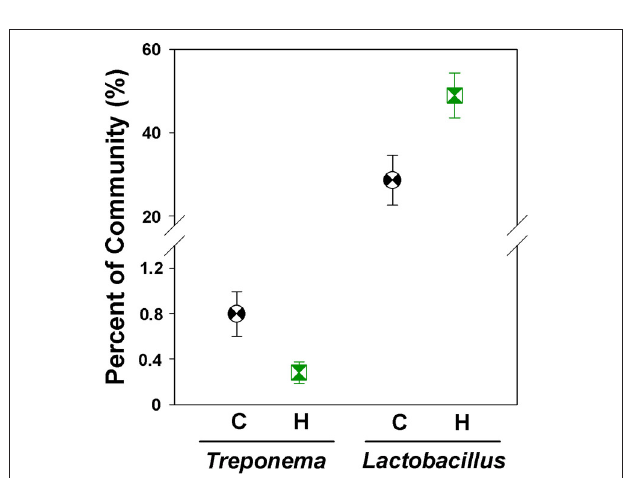
FIGURE 6 | Relative abundances of Treponema and Lactobacillus in the foregut chambers of control and herbivorous-selected voles. Points represent mean ± SEM